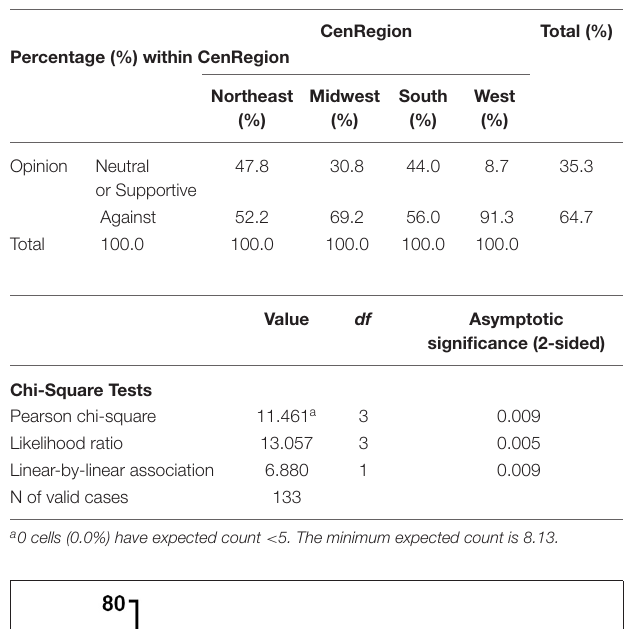
TABLE 2 | CenRegion crosstabulation.